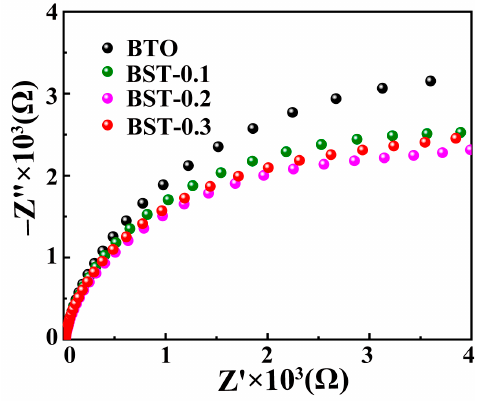
Figure 6. Electrochemical impedance spectroscopy of BST nanopowders.